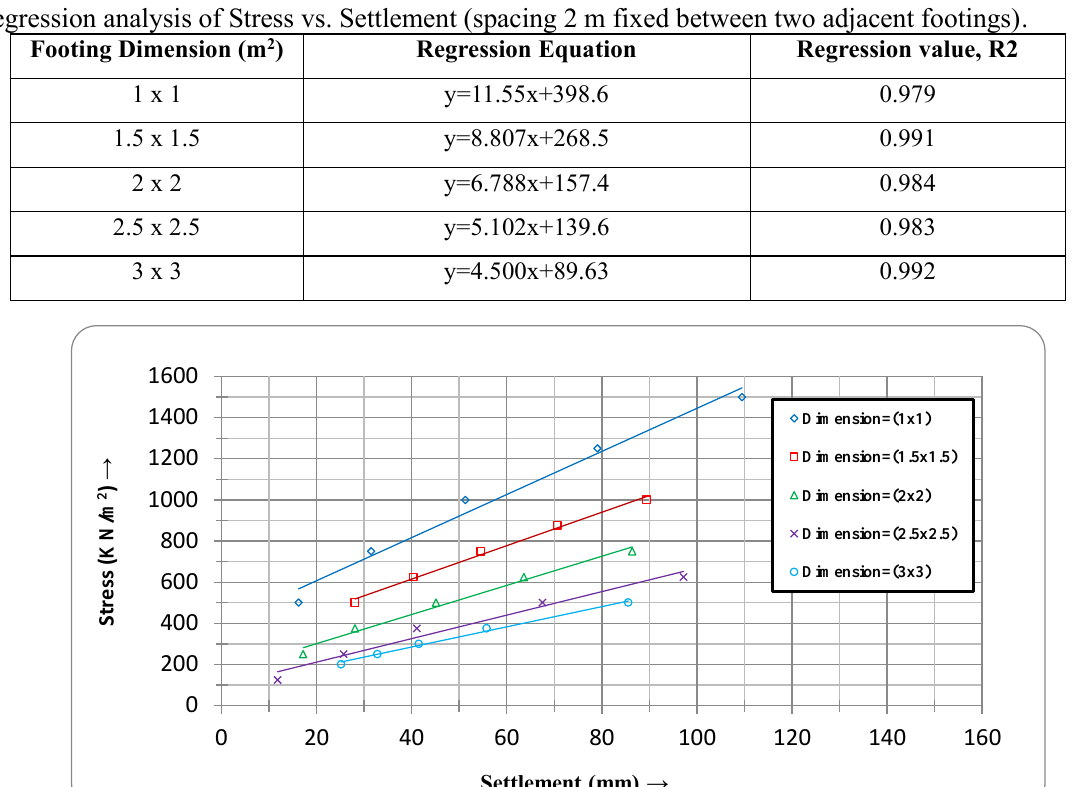
Fig. 19. Stress vs Settlement graph for different footing size (spacing 2.5 m fixed between two adjacent